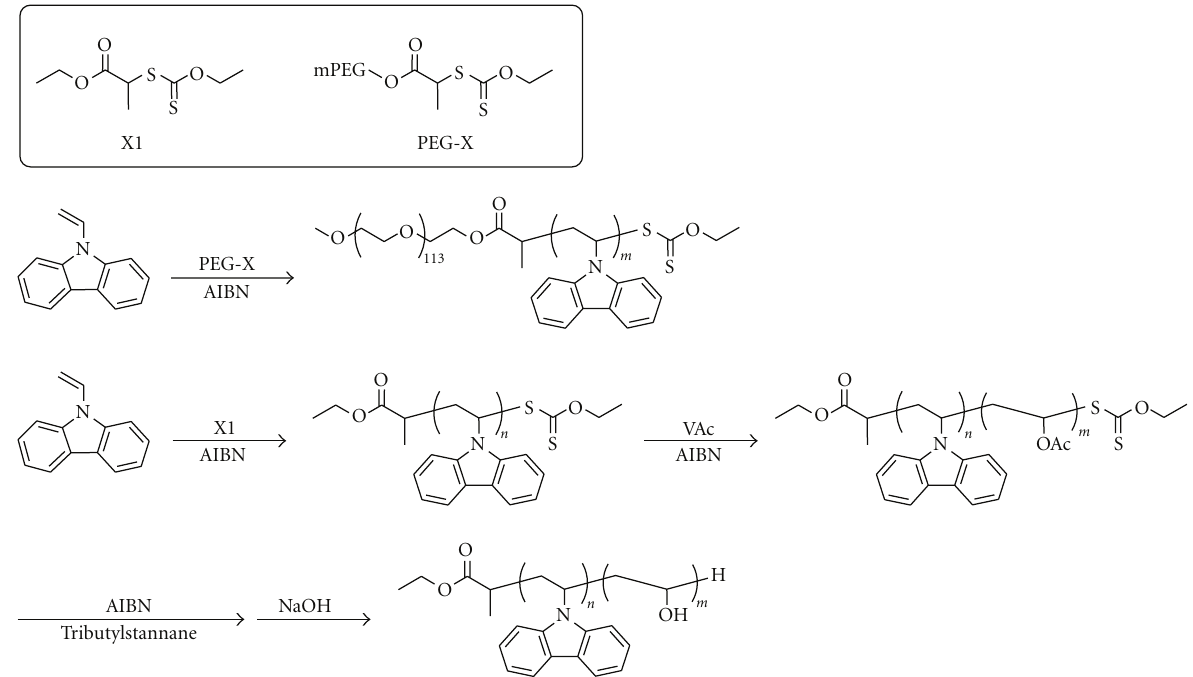
Scheme 5: Synthesis of poly(ethylene glycol)- b -poly(NVC), poly(NVC)- b -poly(vinyl acetate), and poly(NVC)- b -poly(vinyl alcohol) by xanthate-mediated RAFT